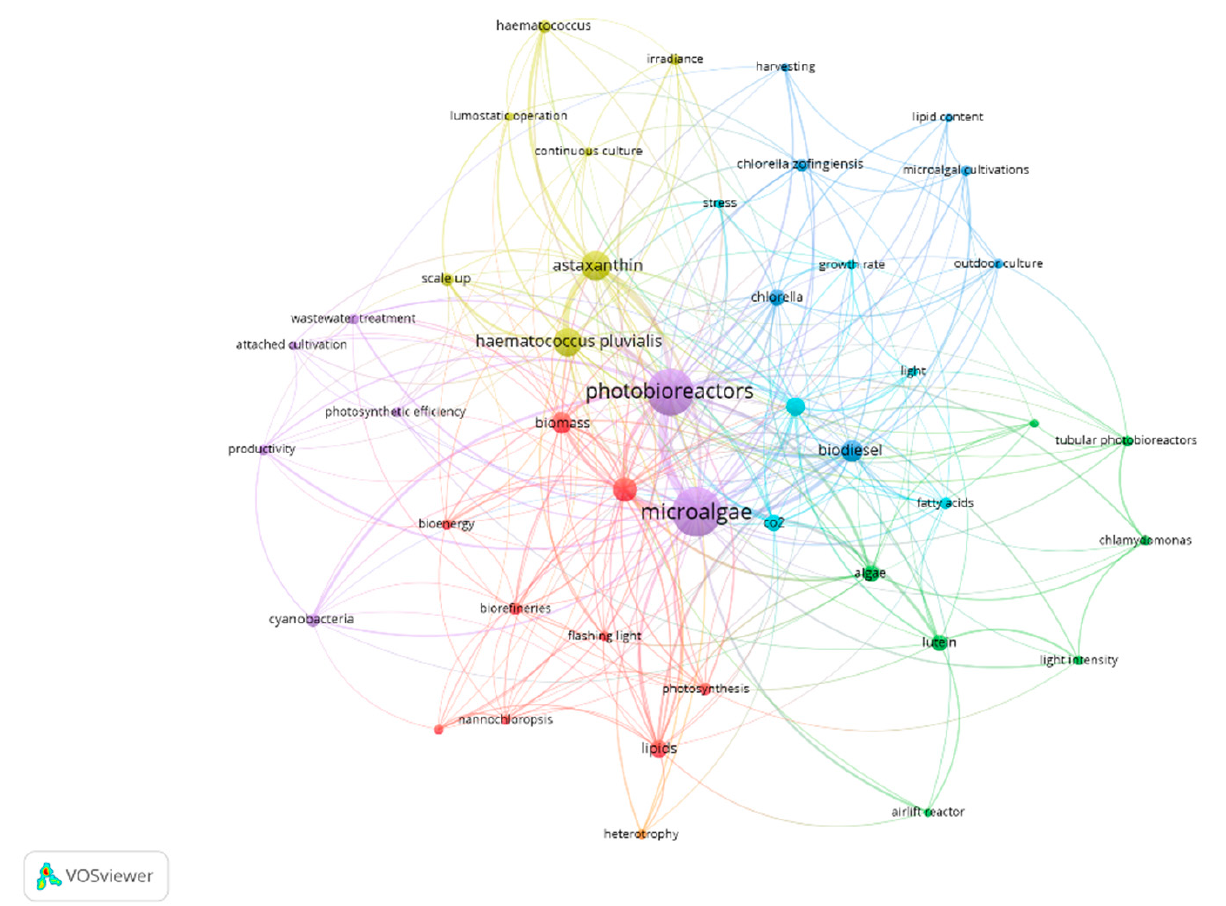
Figure 9. Authors’ keywords’ visualization in the research domain.